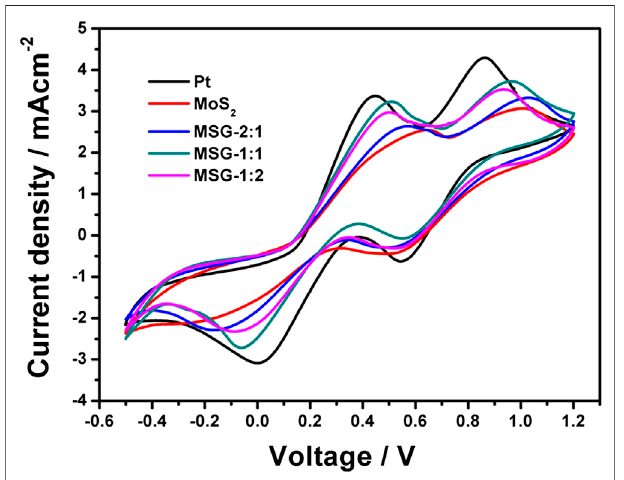
FIGURE 4 | CV curves of MSG-2:1, MSG-1:1, MSG-1:2, MoS 2 , and Pt electrodes.